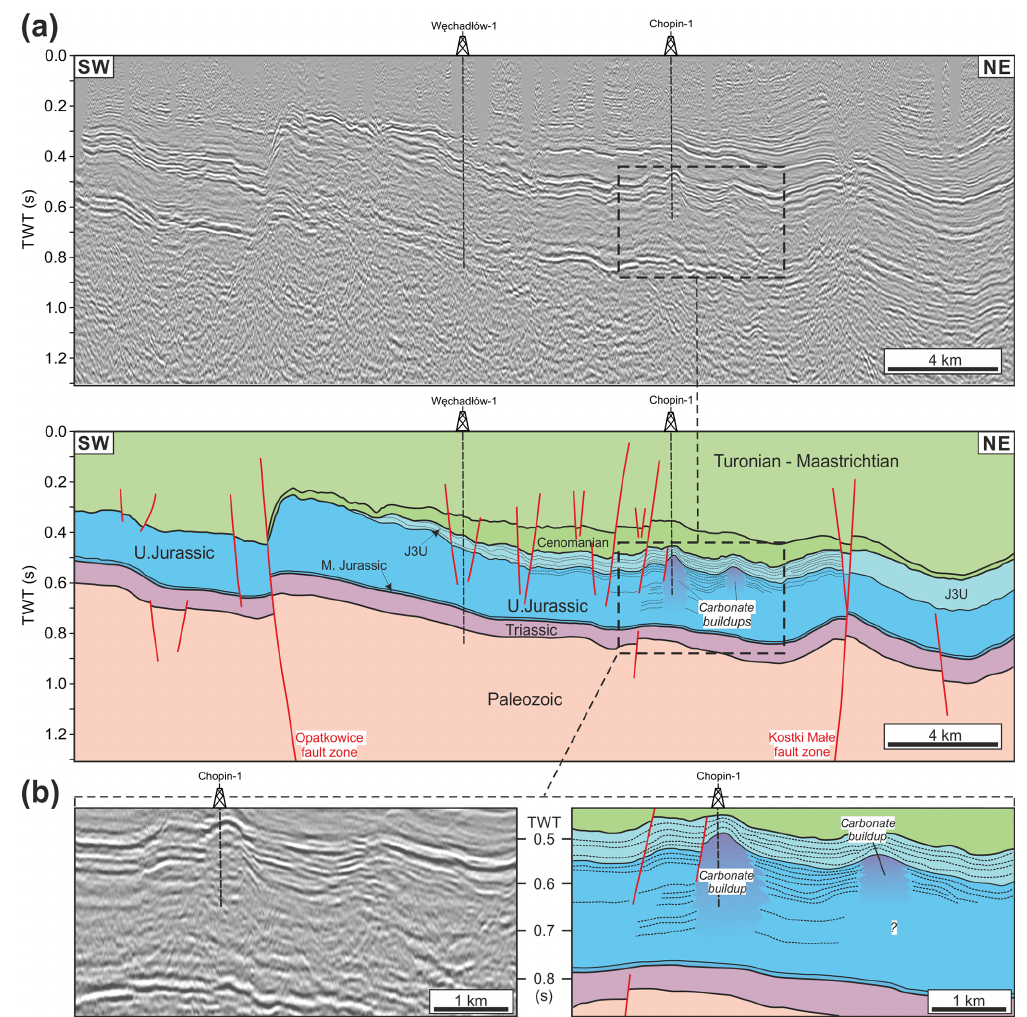
Figure 8. (a) Uninterpreted and interpreted seismic profile (12-5-92K) from the Miechów Trough (see Fig. 5 for location). Major NW– SE-oriented Opatkowice and Kostki Małe fault zones are rooted in the Palaeozoic basement and are associated with inversion anticlines developed within the Mesozoic cover. (b) Two carbonate buildups were identified in this profile, one of which was partly drilled by the SLE Chopin-1